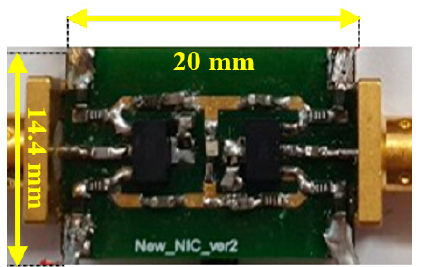
Figure 7. The fabricated non-Forster circuit prototype.